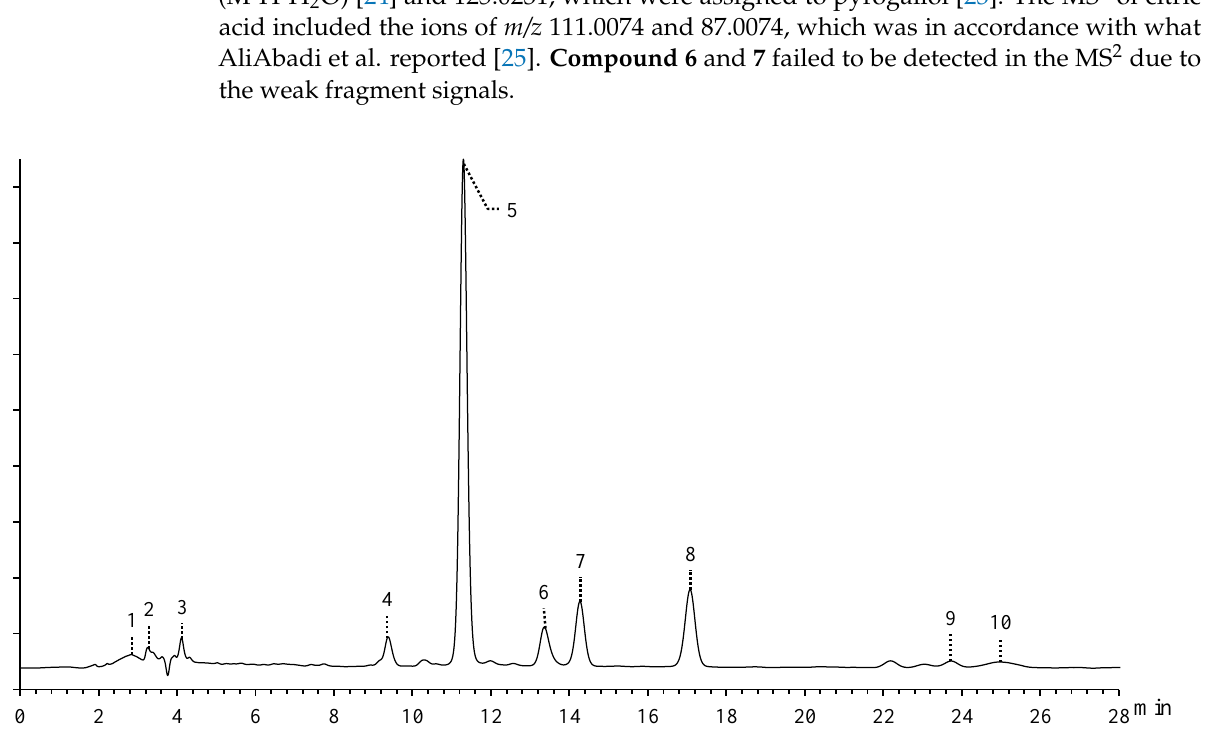
Figure 2. High-performance liquid chromatography with diode array detection (HPLC-DAD) chro- matograms (291 nm) of E-LERW. Compounds are numbered as listed in Table 1. The flavonoid-like compounds from 4 to 9 had the maximum absorbance wavelength of around 290–295 nm [26]. Quercetin and maritimetin included the maximum wavelength of over 300 nm due to longer conjugate